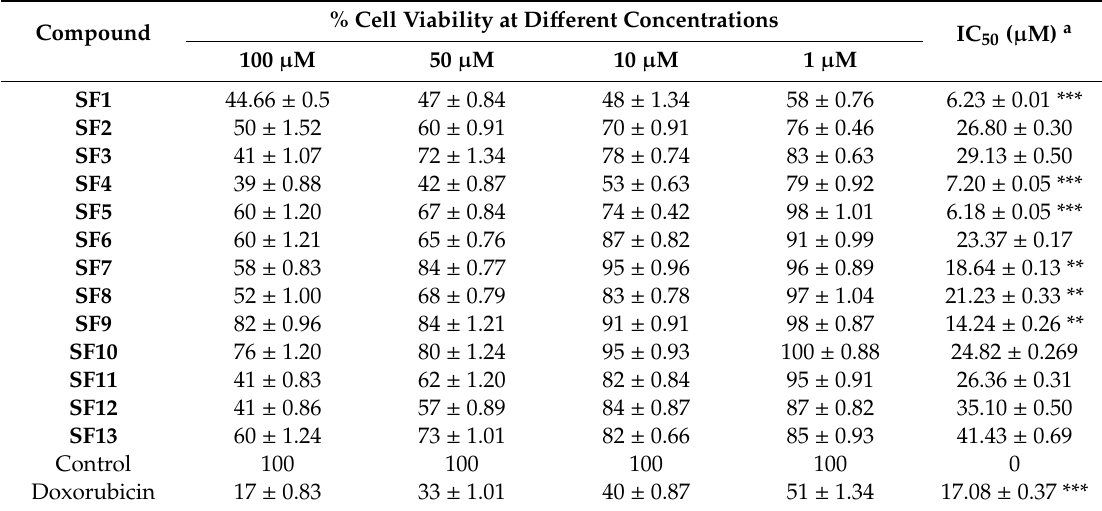
Table 4. Cell cytotoxicity of synthetic compounds at di ff erent